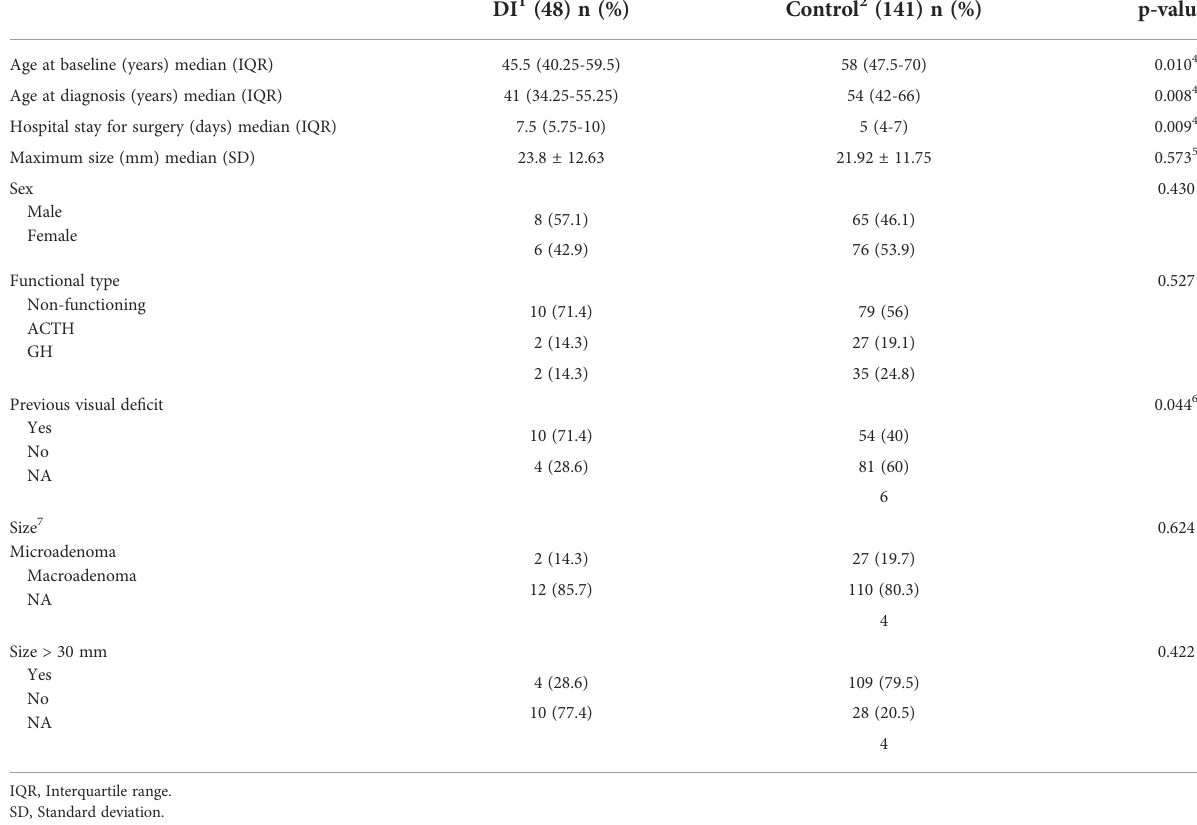
TABLE 3 Diabetes